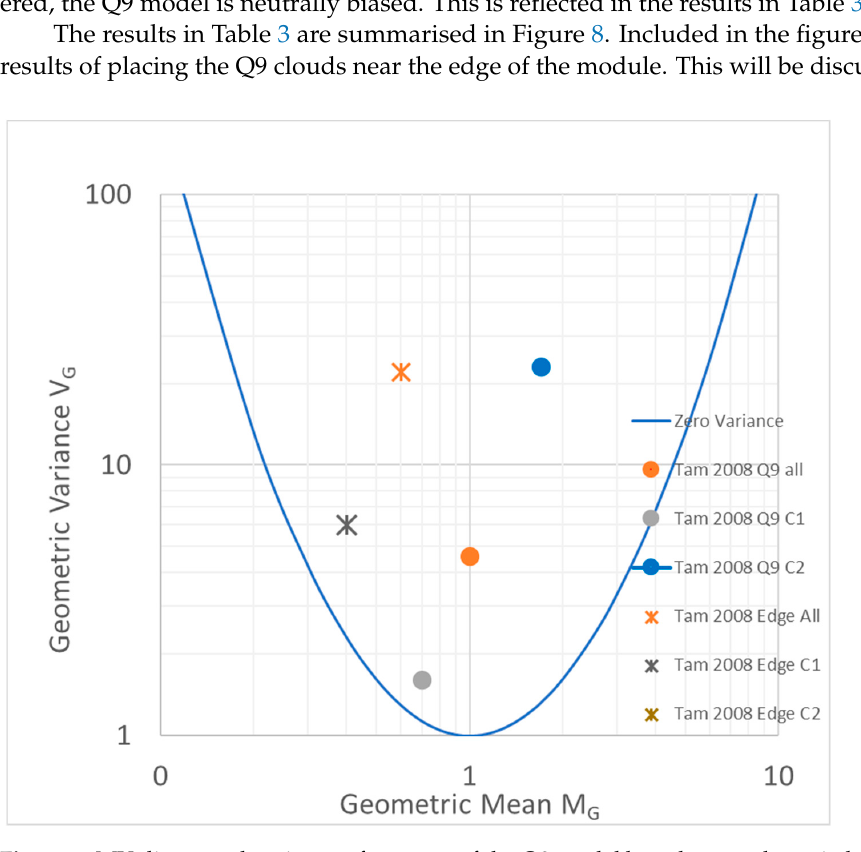
Table 3. Cloud located at locations conducive to generating high overpressures: Geometric Mean and Variance. Maximum P column taken from [2].